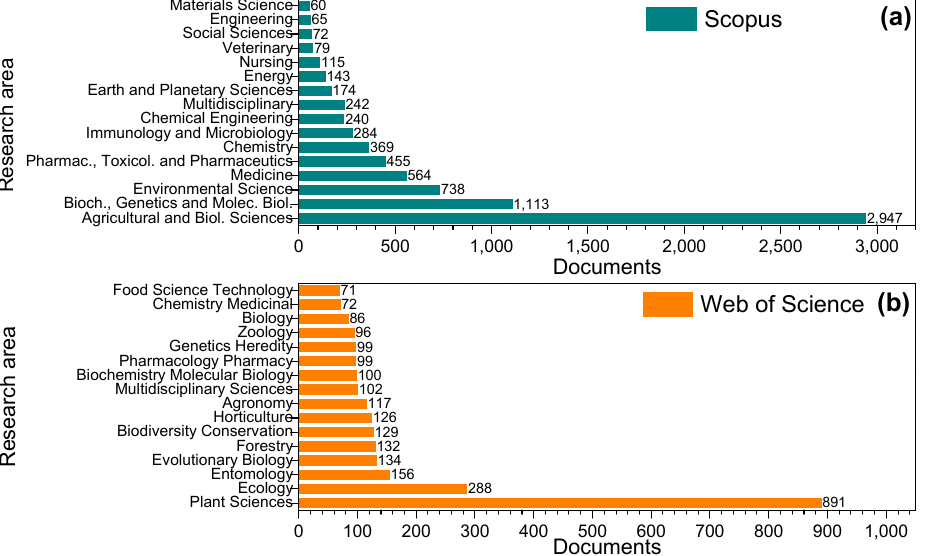
Figure 4. Studies related to Arecaceae on Scopus ® ( a ) and Web of Science ( b ) databases ranked by their main research areas from 1990 to 2021. Adapted from Refs. [24,25]. Accessed on 2 June 2022.